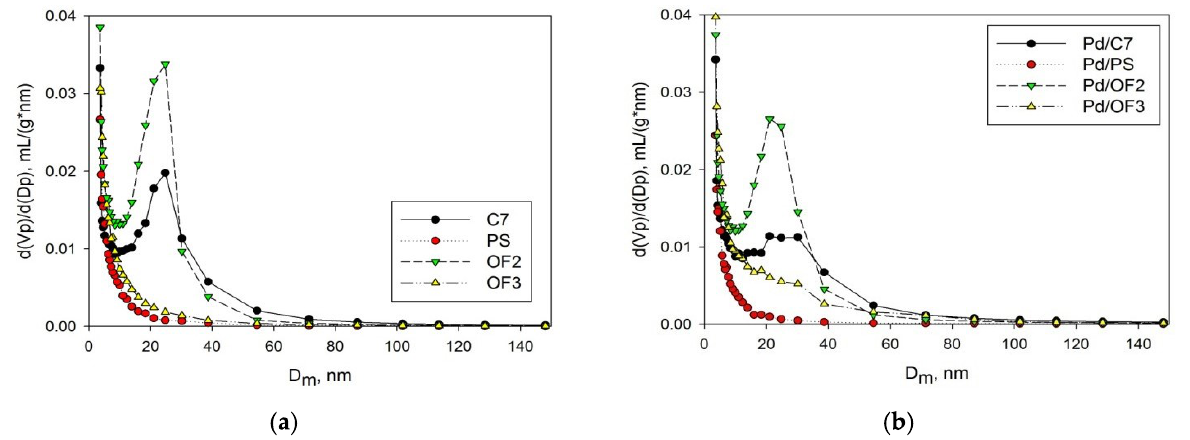
Figure 3. Comparison of pore-volume distributions of synthesized HPS samples ( a ) and Pd/HPS catalysts ( b ).